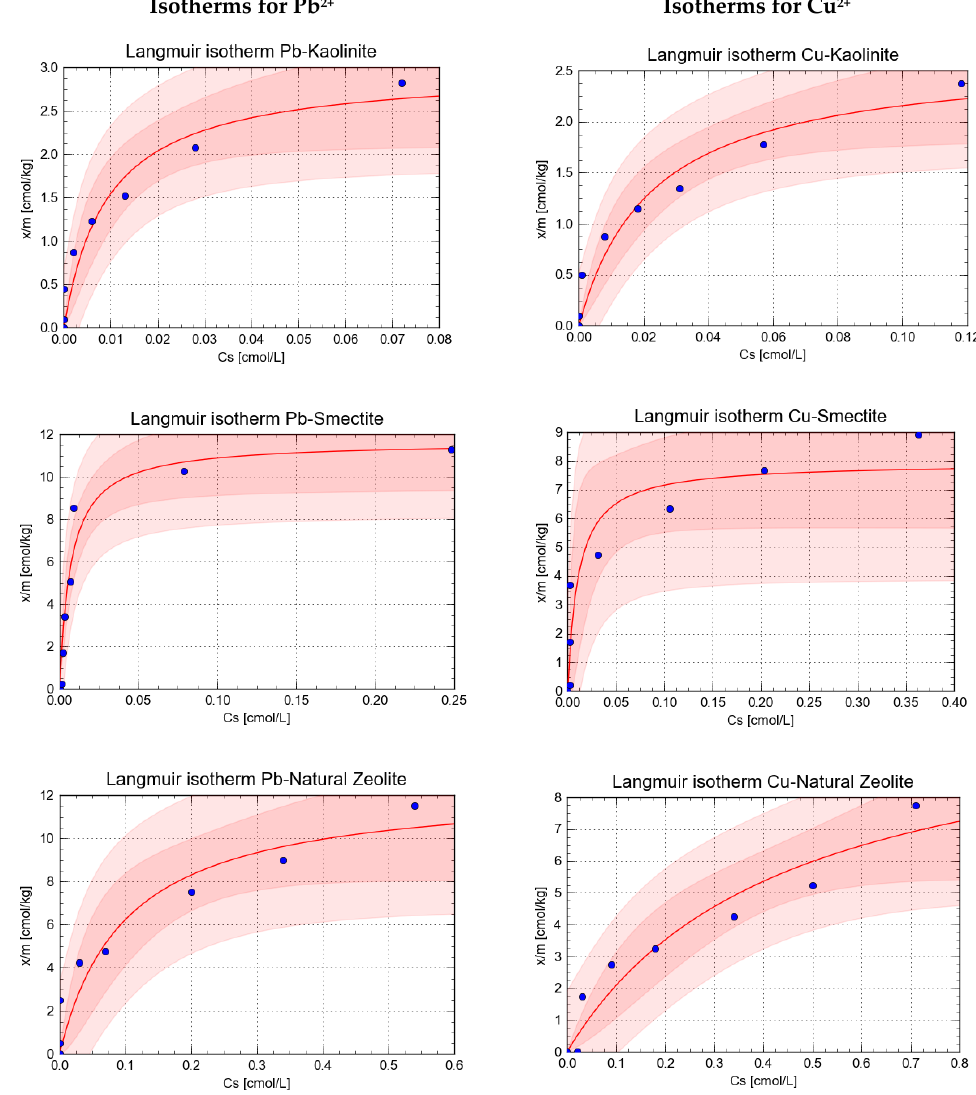
Figure 3. The Langmuir isotherms obtained in the study for sorption of Pb 2+ and Cu 2+ onto tested natural mineral sorbents.